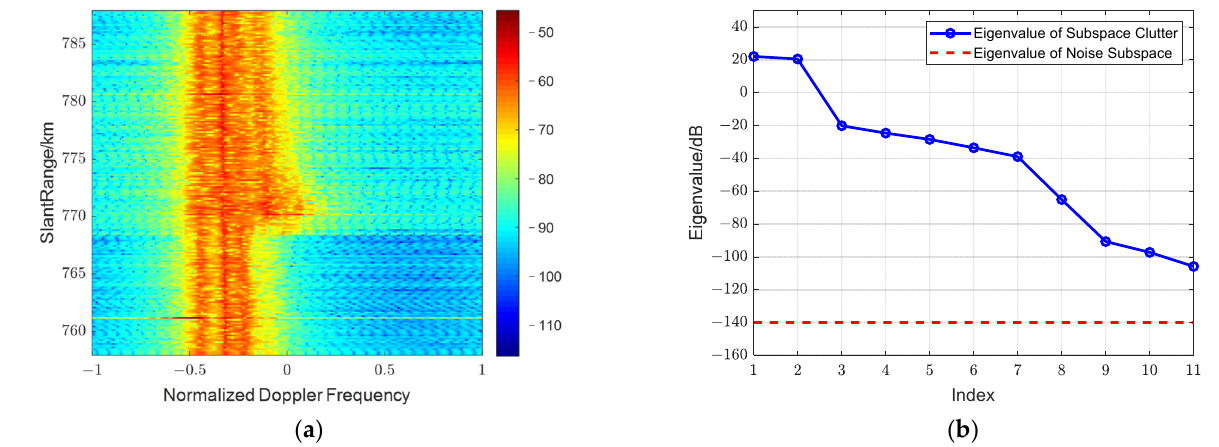
Figure 14. ( a ) The range-Doppler output power spectrum after using method 3.d; ( b ) The eigenvalue spectrum of reduced dimensional clutter covariance matrix.